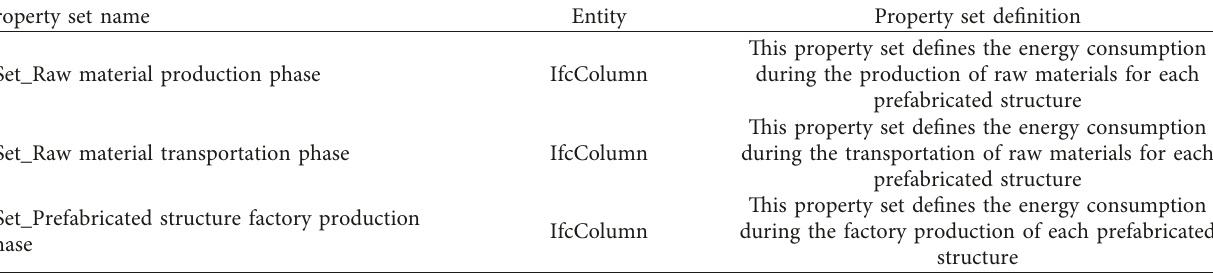
Table 4: Definitions of property sets of prefabricated columns production.